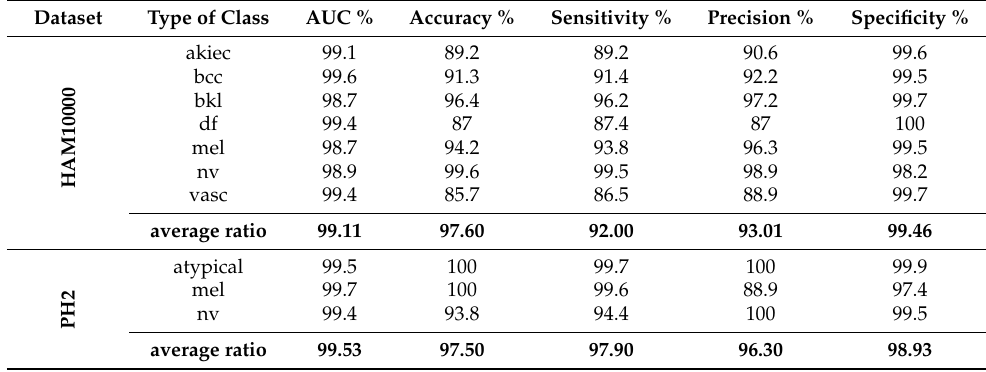
Table 9. Performance of ANN with fused features of ResNet101 and handcrafted for dermoscopic image analysis to classify HAM10000 and PH2 dataset skin